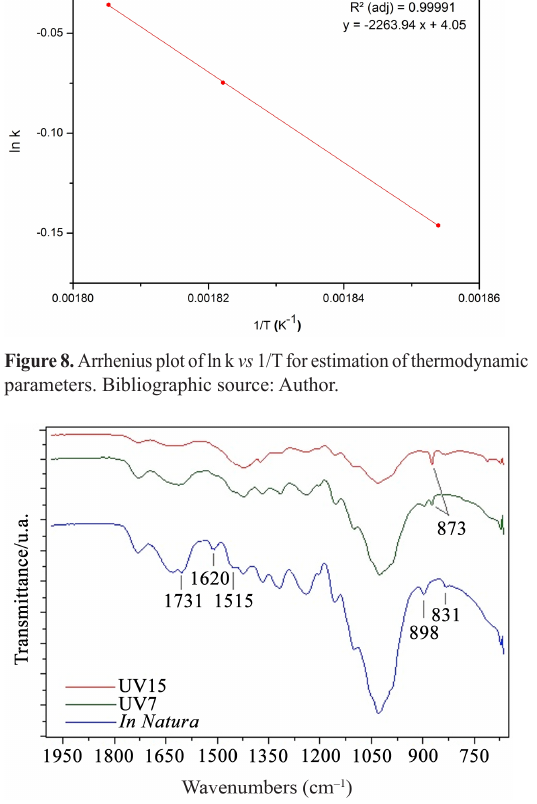
Figure 9. FT‑IR spectra of In Natura , UV7 and UV15 BFs. Bibliographic source: Author.